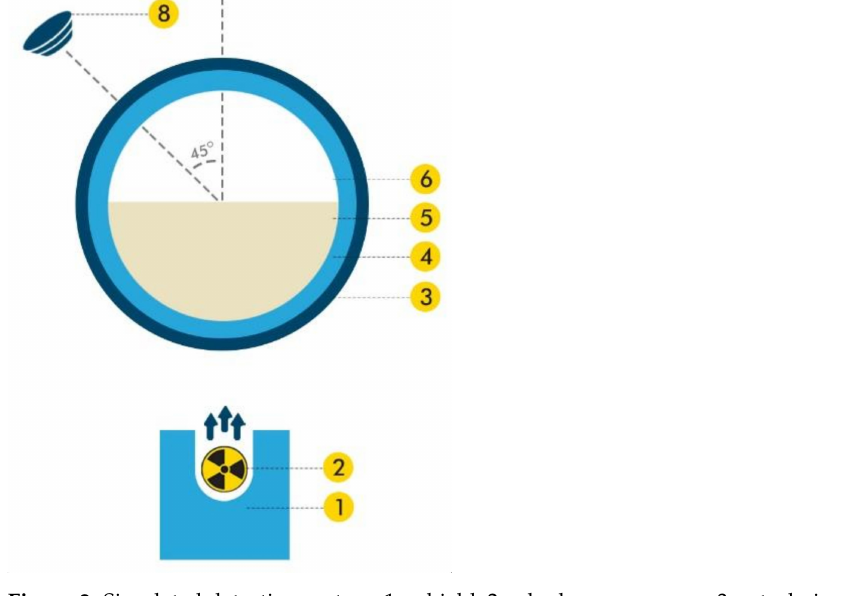
Figure 2. Simulated detection system: 1—shield, 2—dual energy source, 3—steel pipe, 4—scale layer, 5—liquid phase, 6—gas phase, 7—transmission detector, 8—scattering